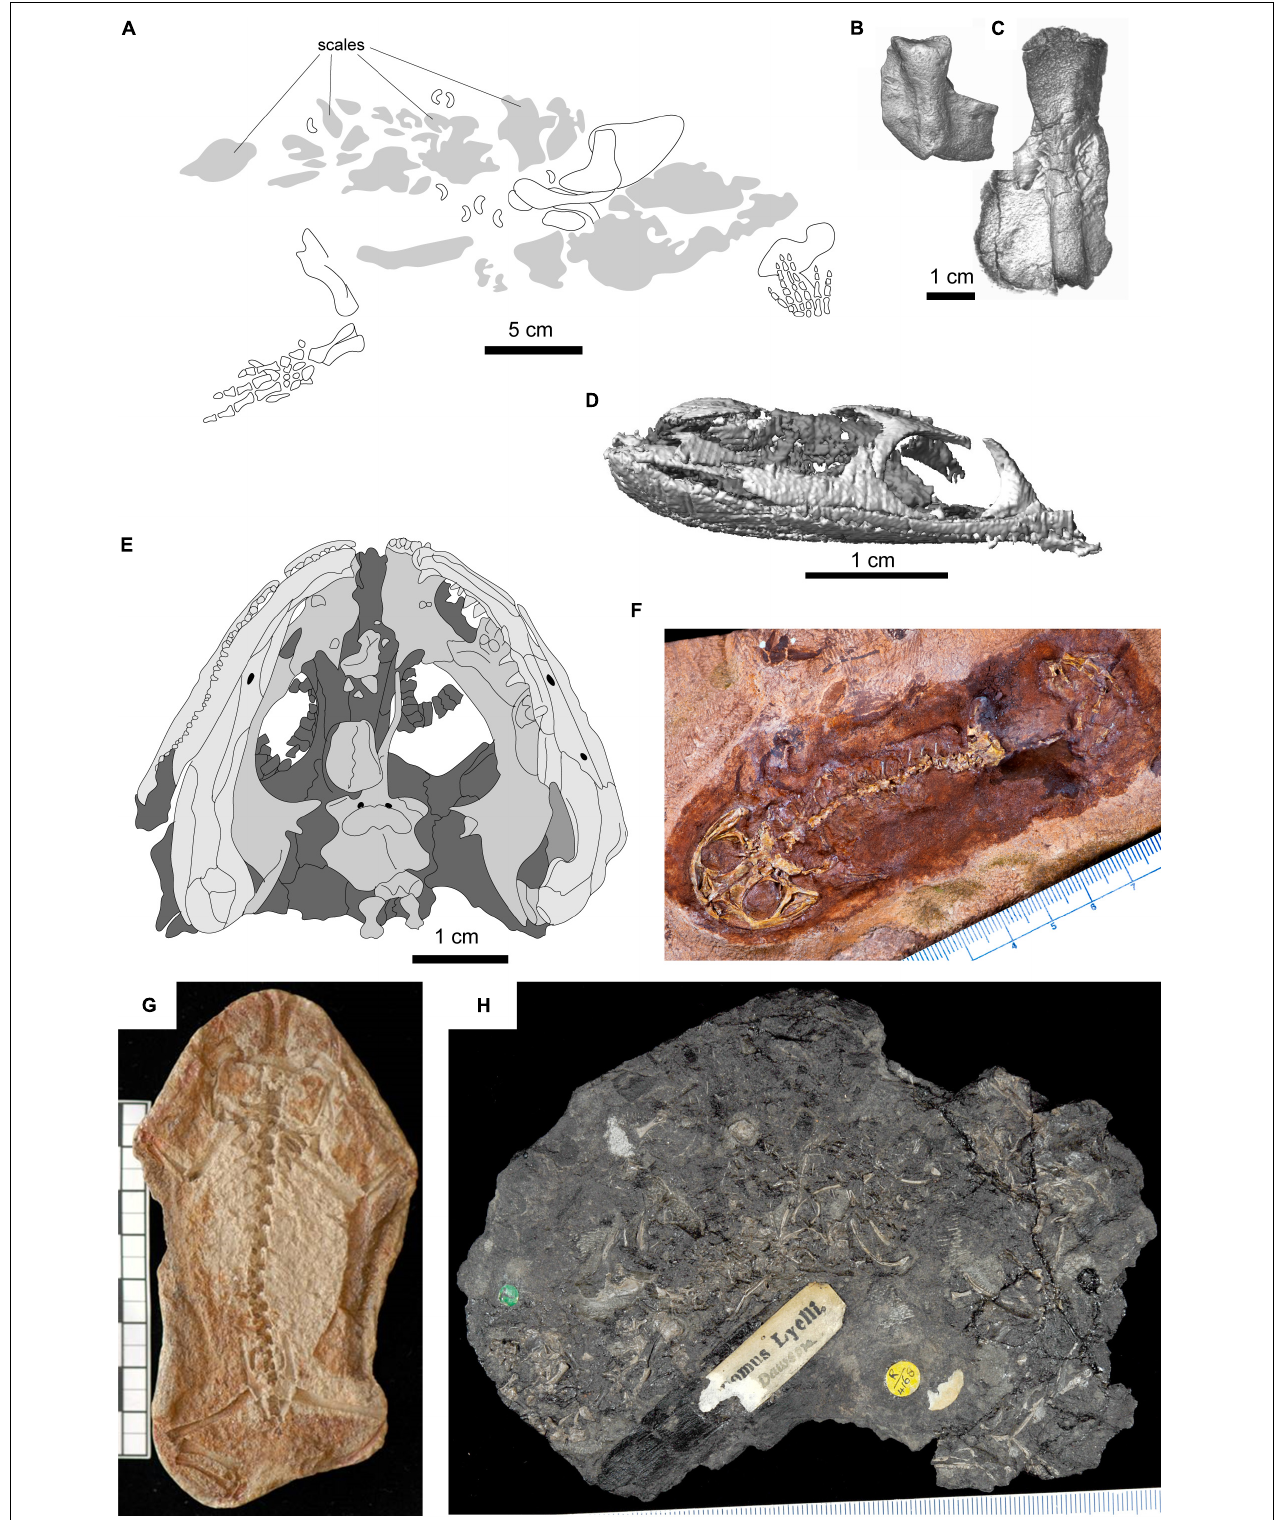
FIGURE 3 | Selected fossils representing node-age calibrations. (A) Tulerpeton curtum , after Lebedev and Coates (1995); (B) Horton Bluff colosteid-like taxon; (C) Horton Bluff embolomere-like taxon; (D) Lethiscus stocki , segmented skull based on micro-CT; (E) type specimen of Balanerpeton woodi , after Milner and Sequeira (1993); (F) Gerobatrachus hottoni ; (G) Triadobatrachus massinoti ; (H) type specimen of Hylonomus lyelli .